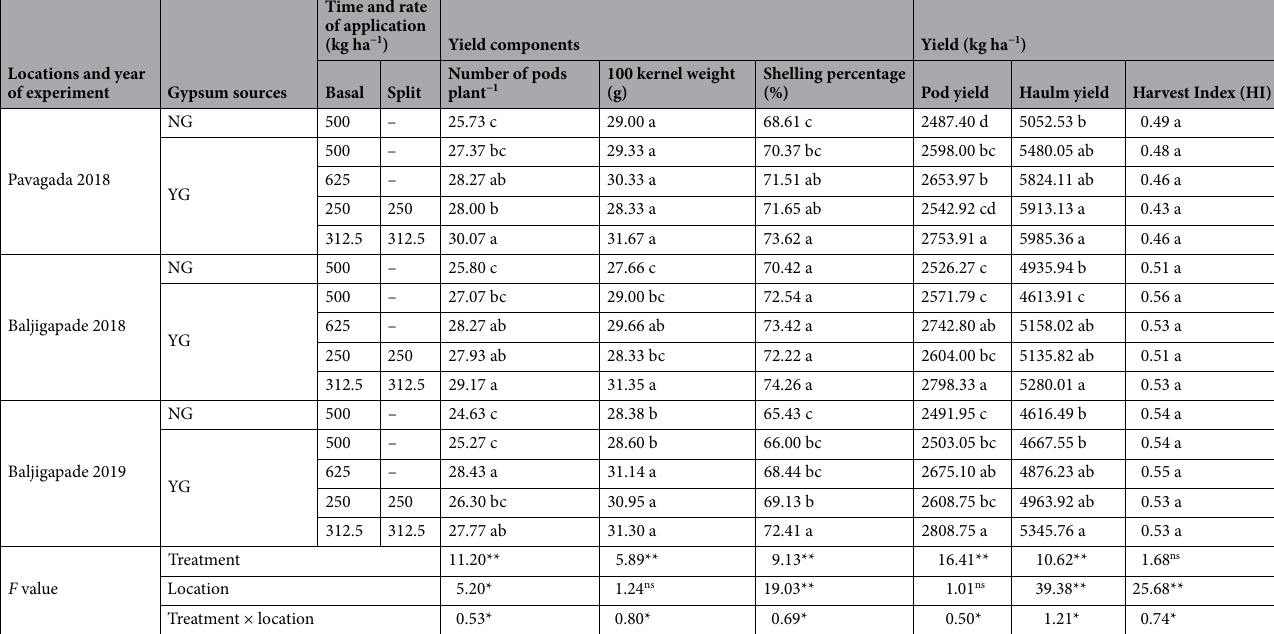
Table 3. Effect of different sources, time and rate of application of gypsum application on yield and yield components of groundnut. F value and significance level (**P < 0.01, *P < 0.05 and ns P ≥ 0.05). Values followed by a different letter within the same column and the same year are significantly different at P < 0.05 probability level. YG yellow gypsum, NG natural